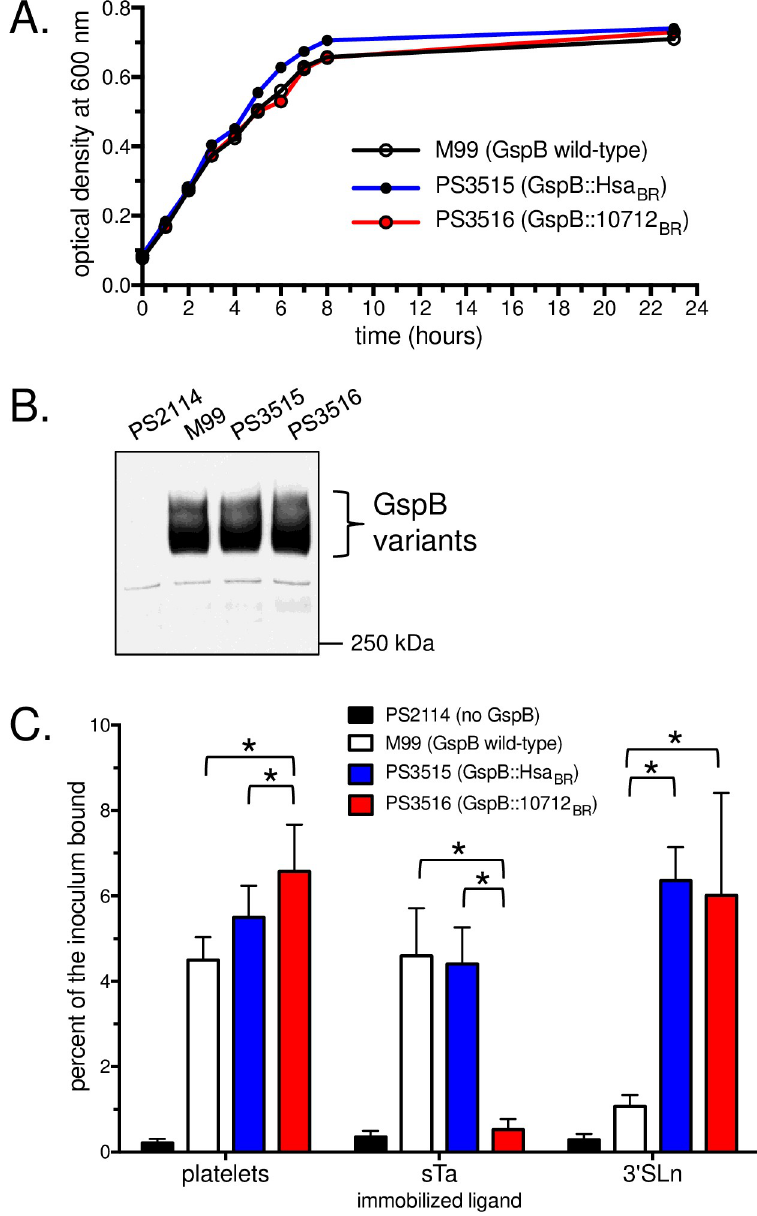
Fig 4. Characteristics of the chimeric SRR glycoprotein S . gordonii strains. A: The isogenic variant strains show growth rates similar to M99. Strains were grown for 17 h in Todd-Hewitt broth, then diluted 1:10 into fresh medium and incubated at 37˚C for 23 h. B: The chimeric SRR glycoproteins display normal cell-surface expression levels and apparent molecular masses. Each lane contains cell wall proteins extracted from bacteria in 75 μ l of stationary-phase cultures (roughly 75 x 10 6 CFU). Blots were probed with polyclonal antibodies that recognized the glycan moieties on GspB. C: Binding properties of the isogenic variant strains. Fixed human platelets or biotinylated glycans were immobilized in 96-well plates. Binding is reported as the mean ± standard deviation of the percent of input streptococci adherent after 90 min (n = 6). Asterisks indicate p < 0.05. significantly lower than those of M99 (p = 0.001). Levels of PS3515 were intermediate between those of M99 and PS3516, but not significantly different from either (Fig 6B). No significant differences were seen in the numbers of bacteria in the peripheral blood at either inoculum